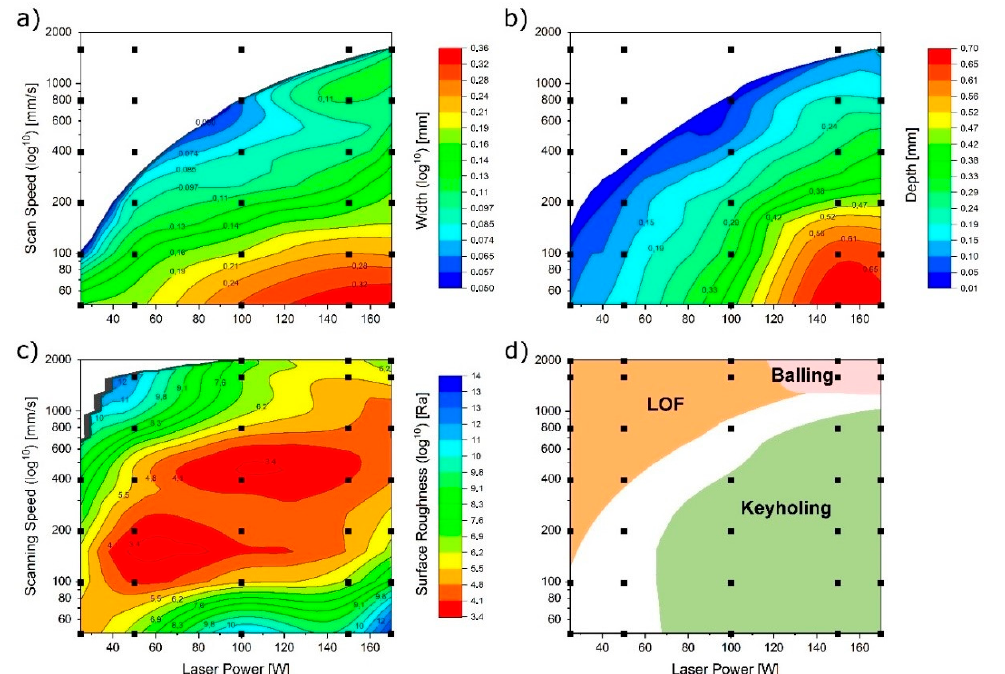
Figure 7. Exemplary resulting information of step 2 for MS1 ( t = 30 µm). Black squares mark points of measurement and interpolation. ( a ) Fuse width. ( b ) Fuse depth. ( c ) Surface roughness. ( d ) Printability map. ( D/t < 1.5, L/W > 2.3 and W/D < 1.5).